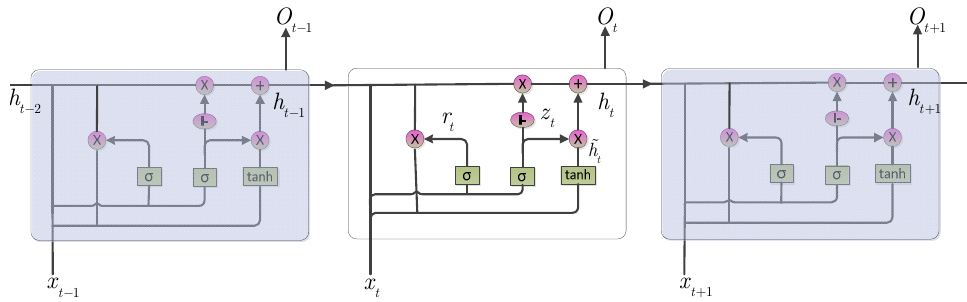
Figure 3. Typical structure of a gated recurrent unit (GRU) neural network. O t ( h t ) is the output at time t ; r t denotes the reset gate, which determines the combination of current input and historical memory information; and, z t is the update gate, which determines the proportion of memory left behind.